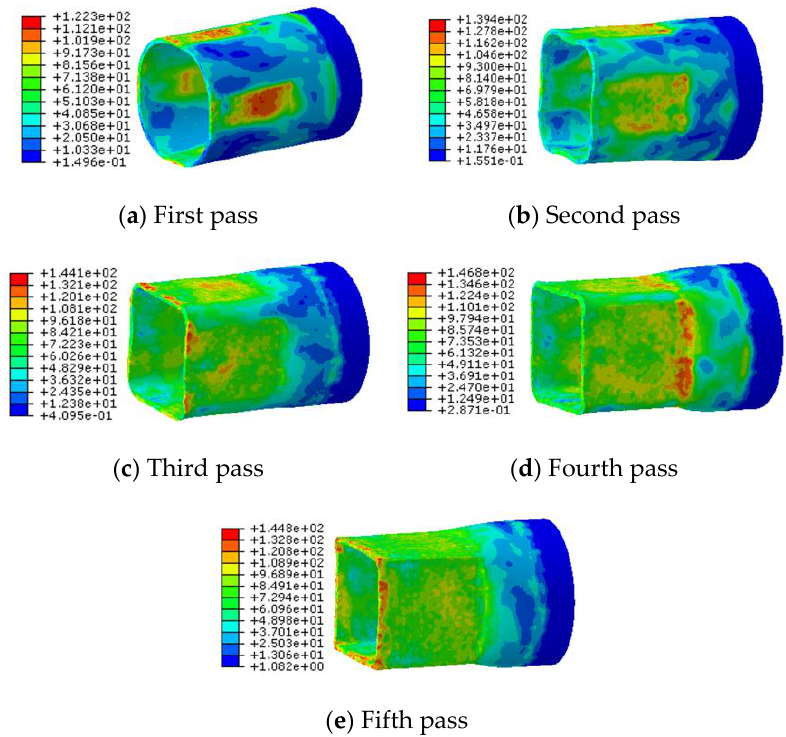
Figure 5. Distribution of equivalent von Mises stress after each pass of the non-circular spinning process.